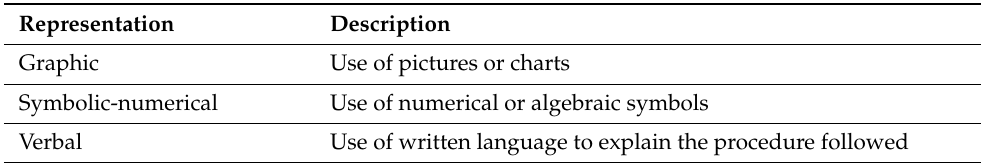
Table 4. Categories used to analyse representations.